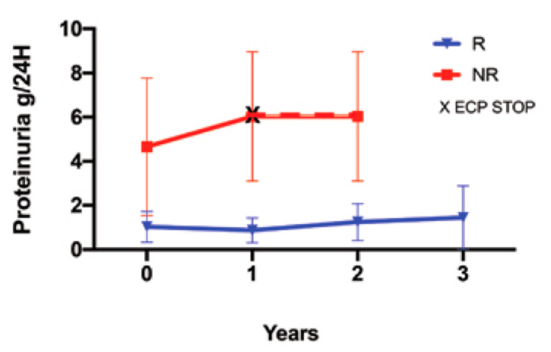
Figure 4. 24 h proteinuria was evaluated after the ECP treatment in the responder (R) patients (blue line) and the non-responder (NR) patients (red line). In the R patients, the ECP treatment was prolonged by up to 3 years, showing the stabilization of the proteinuria at the last follow up. The black cross marks the end of the ECP treatment in the NR group. The red dashed line marks the follow up after the ECP stoppage in the NR group. The data are expressed as the mean and SD.